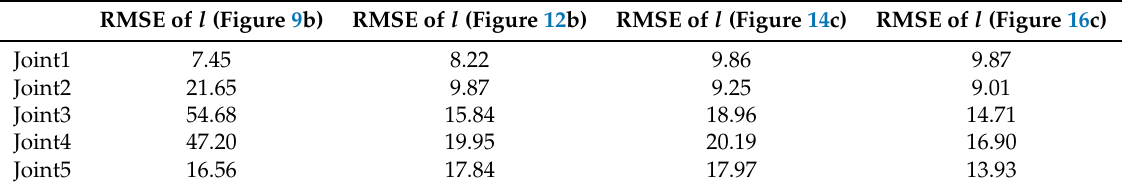
Table 3. RMSE of cable displacement l ( × 10 − 4 cm).